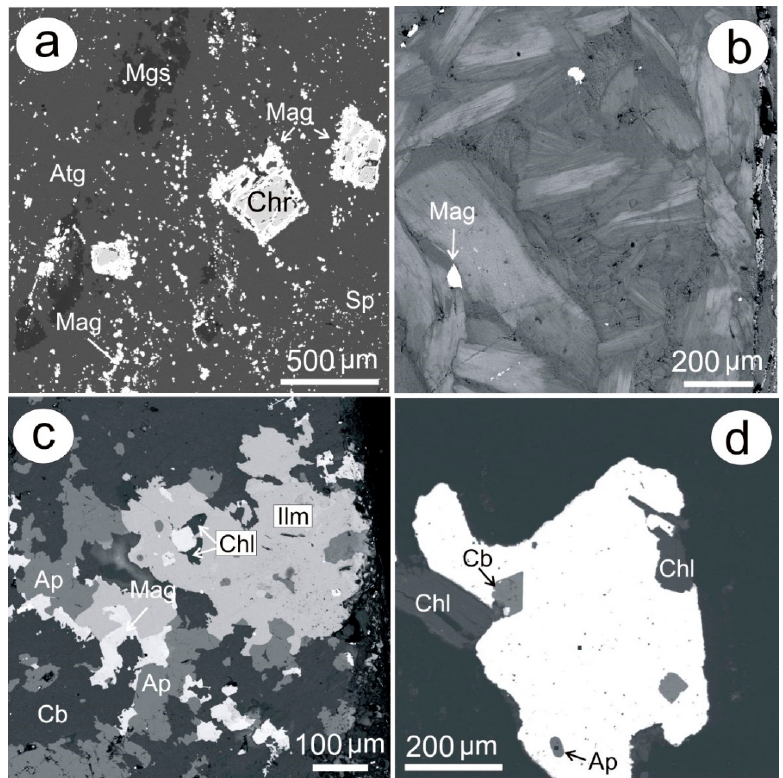
Figure 4. Relationships between minerals in altered ultramafic rocks from the Karabash massif. Back-scattered electron images of polished sections [8]: ( a ) Serpentinite including antigorite (Atg) with dispersed magnesite (Mgs), magnetite (Mag), and chromspinel (Chr). Chromspinel is replaced by magnetite. ( b ) Chloritolite composed of zoned chlorite grains with scarce impregnation of magnetite (Mag). Central parts of chlorite grains (light gray) contain 12–16 wt % FeO, marginal parts (dark gray), 5–7 wt % FeO. Magnetite-chlorite-carbonate rock: ( c ) intergrowths of apatite (Ap), ilmenite (Ilm), magnetite (Mag), chlorite (Chl), and carbonate (Cb); ( d ) copper gold with inclusions of chlorite (Chl), apatite (Ap), and carbonate (Cb).